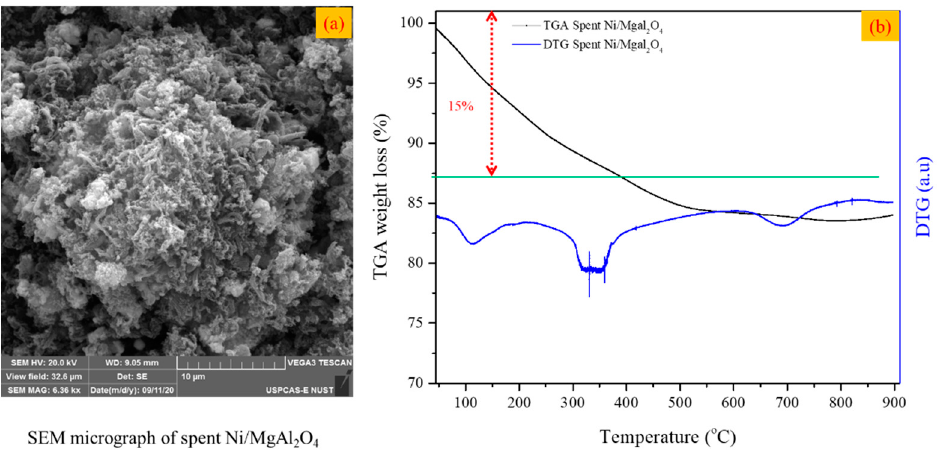
Figure 10. Spent Ni / MgAl 2 O 4 after 16 h TOS analysis ( a ) SEM micrograph ( b ) TGA-DTG Figure 10. Spent Ni/MgAl 2 O 4 after 16 h TOS analysis ( a ) SEM micrograph ( b ) TGA-DTG analysis.